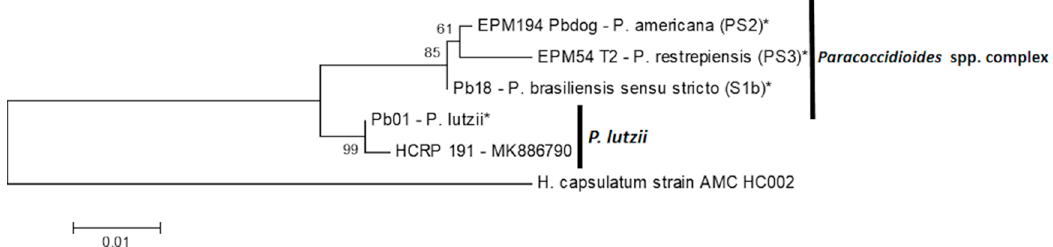
Figure 3. Phylogenetic analysis of the ITS1 ‐ 5.8S ‐ ITS2 rDNA region of the isolate HCRP191 compared to the reference strains (*), that were also sequenced for this study and had a 100% identity with the deposited sequences on GenBank under accession number: [Pb18—B17 ( P. brasiliensis sensu stricto (S1b)), EPM194— Pbdog—( P. americana (PS2)) and EPM54—T2 ( P. restrepiensis (PS3))—KT155977.1 for three reference strains; Pb01—EU870297.1 ( P. lutzii )] and H. capsulatum AMC_HC002 are an external group. Evolutionary history was